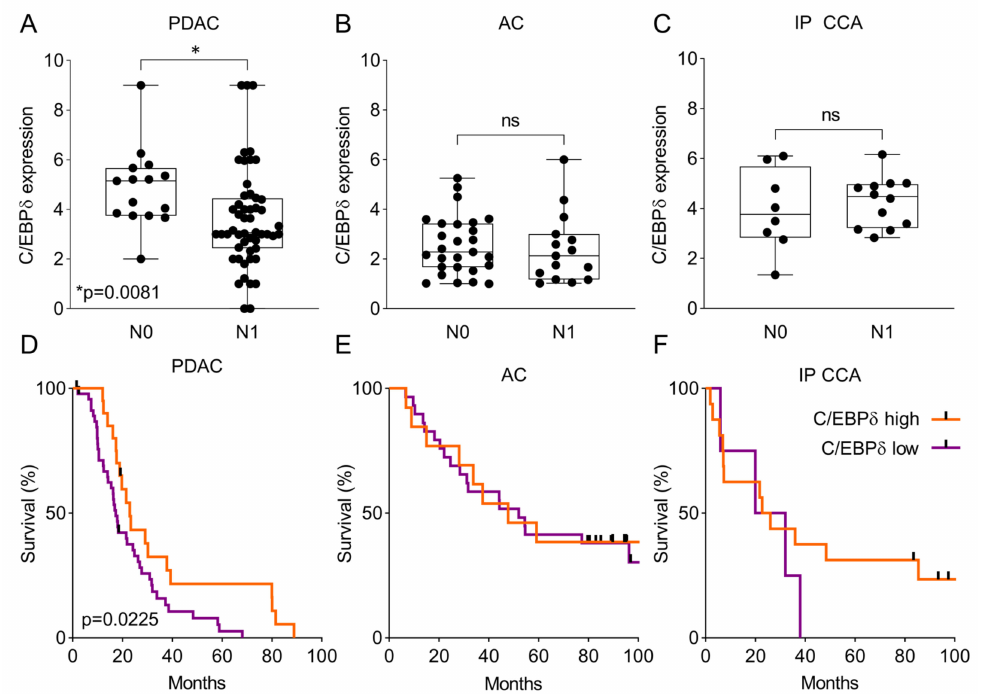
Figure 3. C / EBP δ expression correlates with regional lymph node metastasis and overall survival in pancreatic ductal adenocarcinoma patients. ( A – C ) C / EBP δ expression levels in patients with and without regional lymph node metastasis (N0: negative regional lymph nodes, N1: positive regional lymph nodes) in pancreatic ductal adenocarcinoma ( A ), ampullary carcinoma ( B ) and intrapancreatic cholangiocarcinoma ( C ). ( D – F ) Overall survival in pancreatic ductal adenocarcinoma ( D ), ampullary carcinoma ( E ) and intrapancreatic cholangiocarcinoma ( F ) in di ff erent groups of C / EBP δ expression levels.Vertical black bars in Kaplan-Meier plots represent censored patients. ns: not